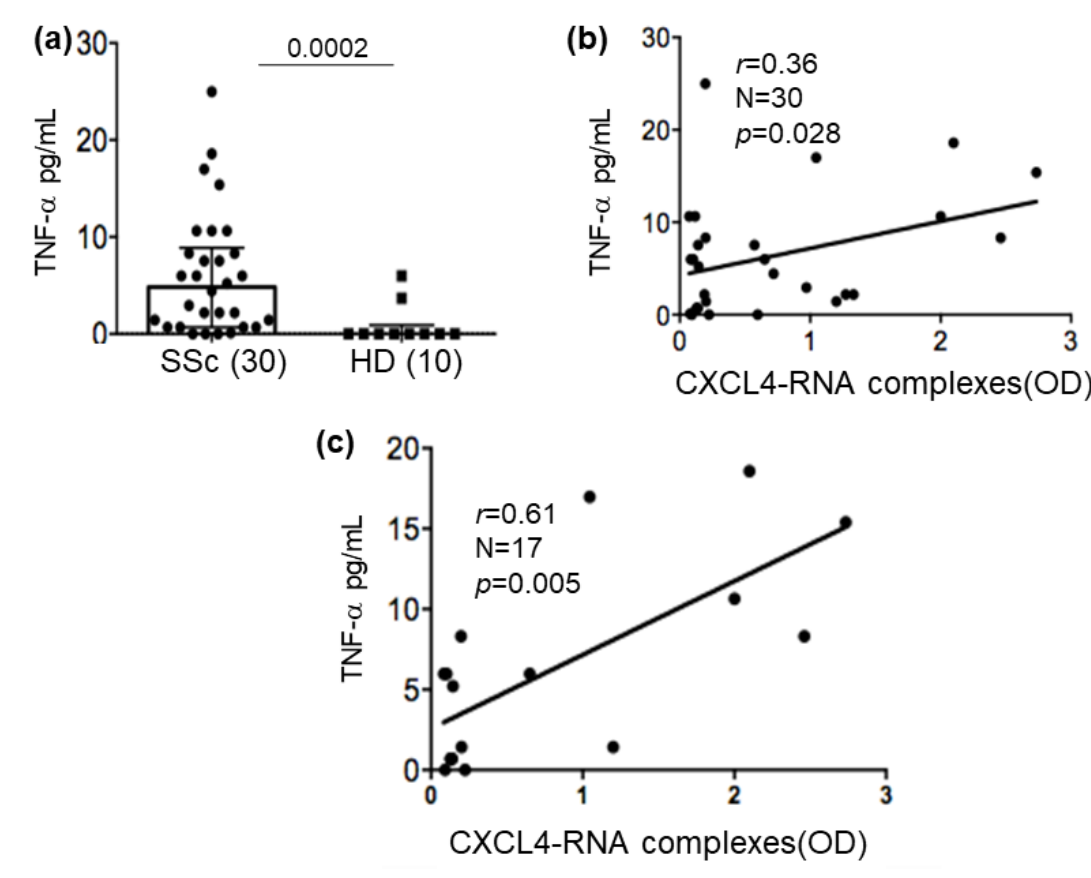
Figure 7. TNF- α in the plasma of SSc patients correlates with CXCL4-RNA complexes. Plasma concentrations of TNF- α were measured by ELISA in SSc and HD samples ( a ), and data on cytokine concentration were plotted against amounts of CXCL4-RNA complexes in the same plasma, expressed as OD ( b ). In ( c ), only SSc plasma samples positive for CXCL4-RNA complexes were selected. p -values in ( a ) are from the Mann–Whitney test; correlations in ( b , c ) were calculated by Spearman’s correlation test. Correlation coefficient r, significance p , and sample size N are reported on the graphs.